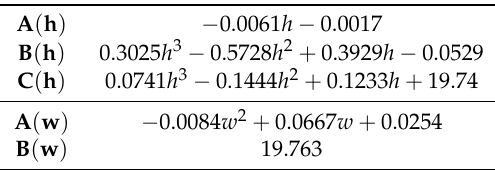
Table A4. Formulas for the coefficients in (8) and (9),